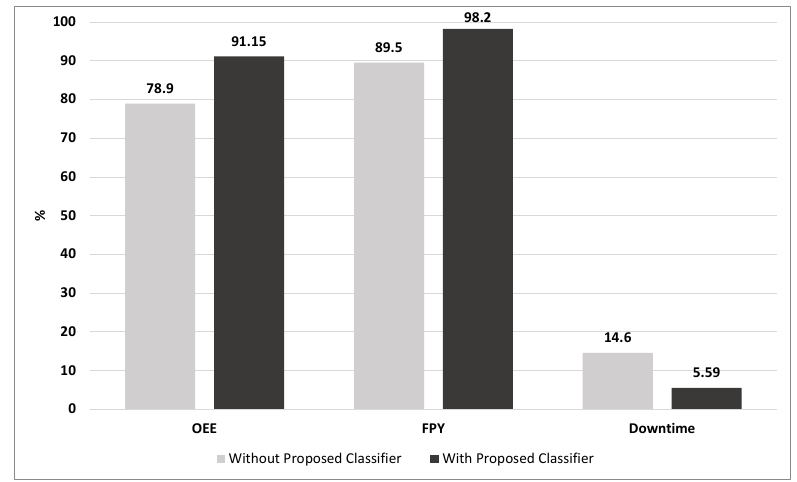
Figure 9. Negri Bossi machine indicators with and without the proposed classifier.